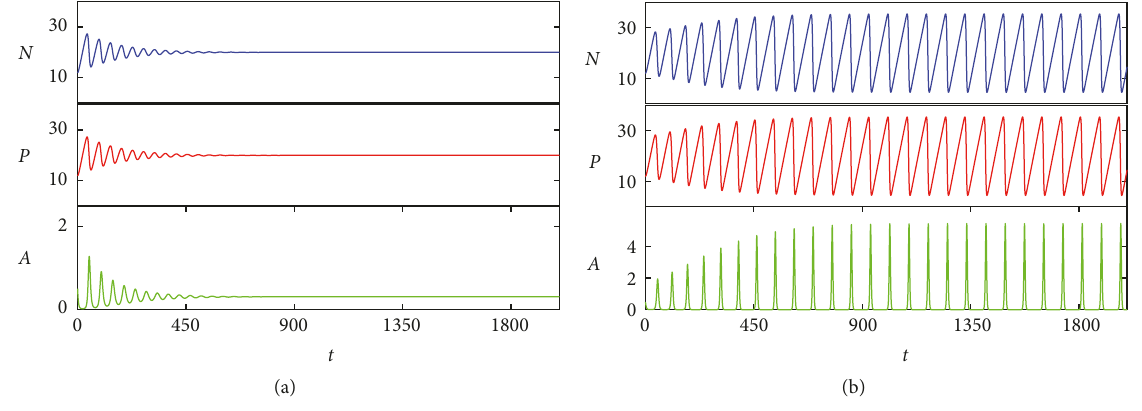
Figure 2: Numerical solutions of model (1) with 𝜏 2 = 0 and 𝛽 2 = 0.2 , (a) 𝜏 1 = 1 ; (b) 𝜏 1 = 3 .